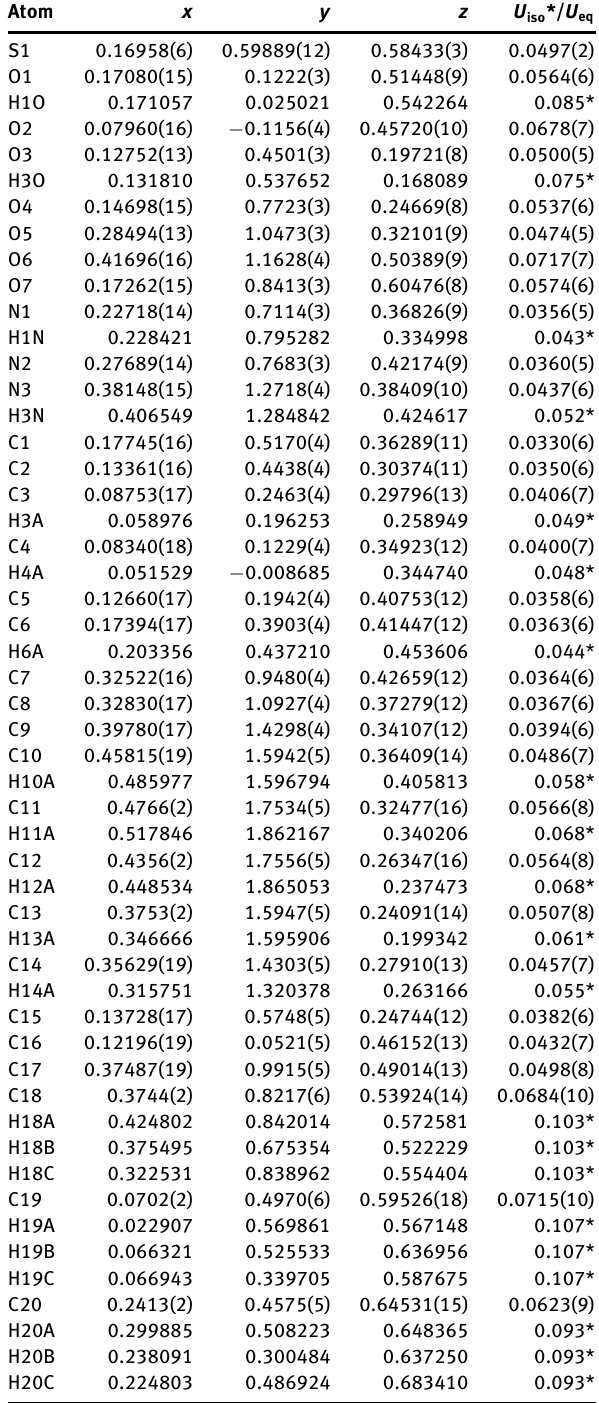
Table 2: Fractional atomic coordinates and isotropic or equivalent isotropic displacement parameters (Å 2